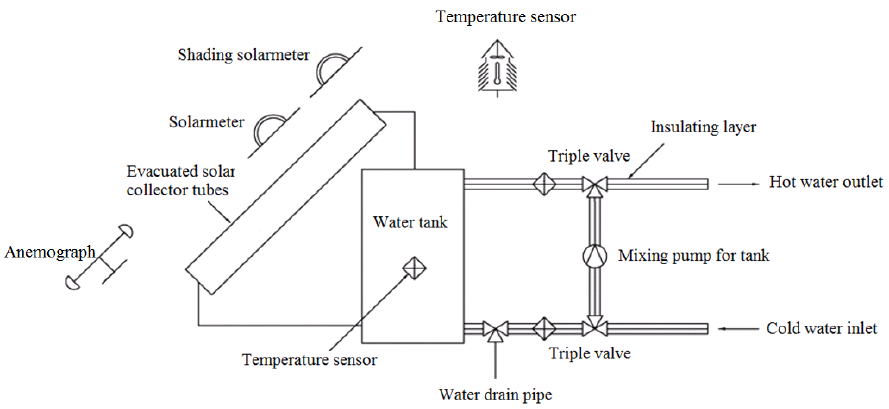
Figure 1. Schematic diagram of detection device of the determination for water-in-glass evacuated tube solar water